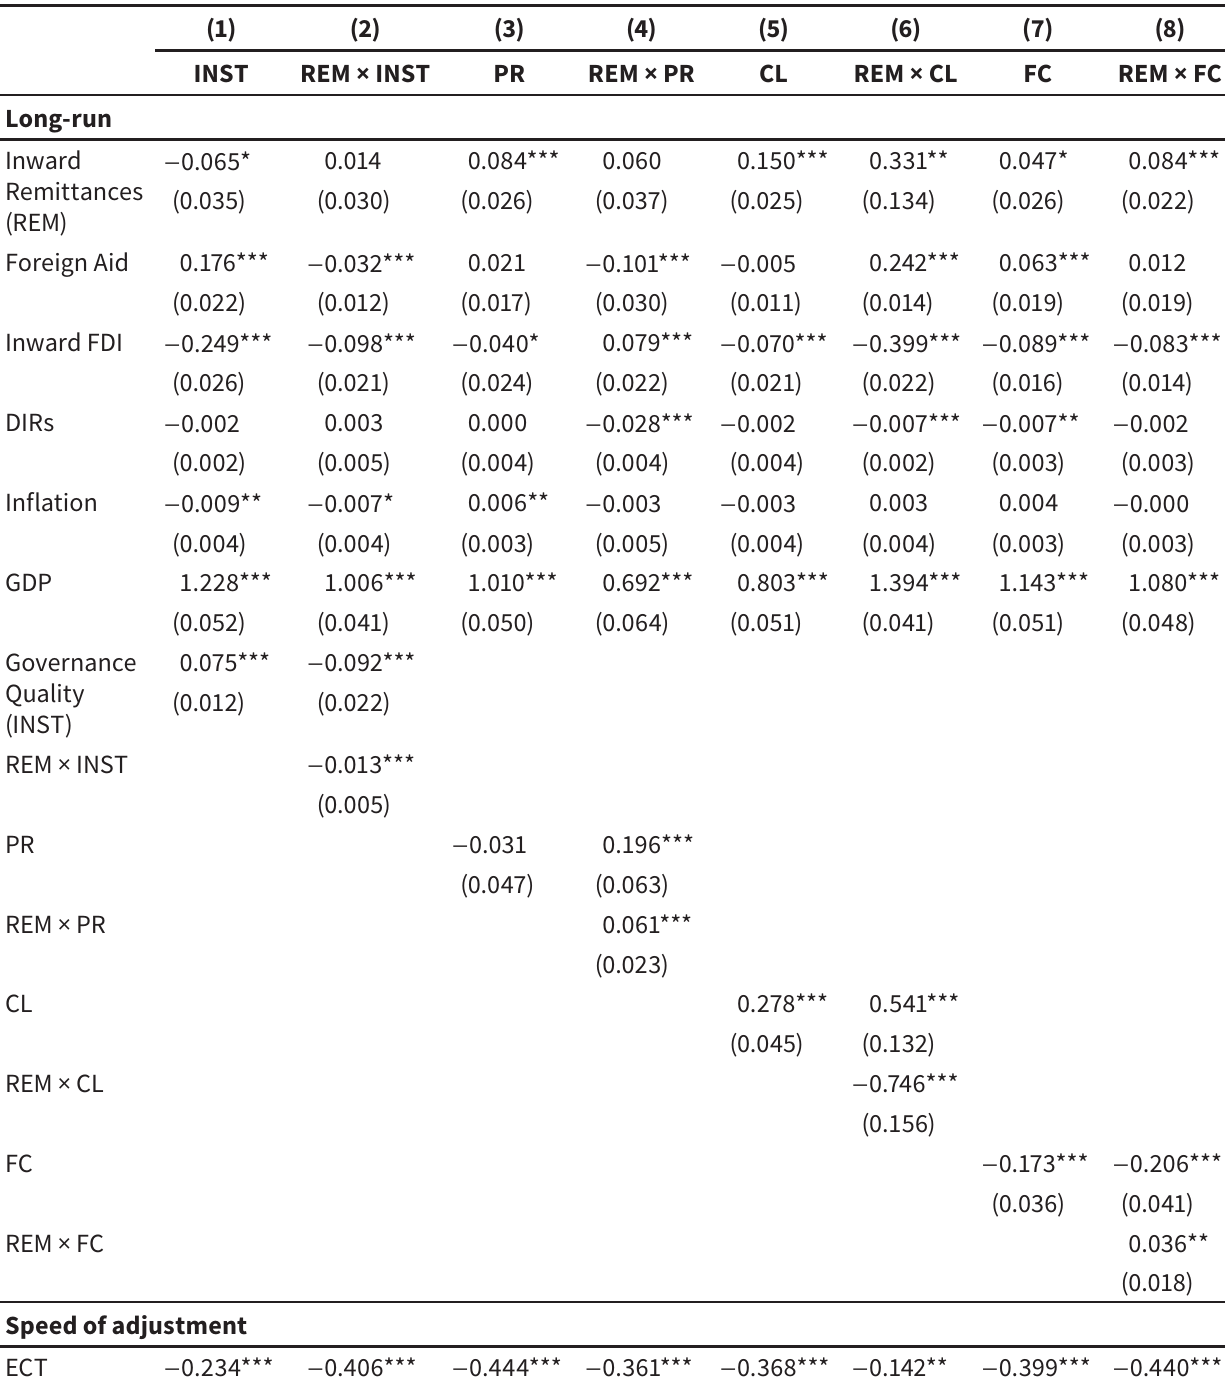
Governance, PR, CL, and FC on